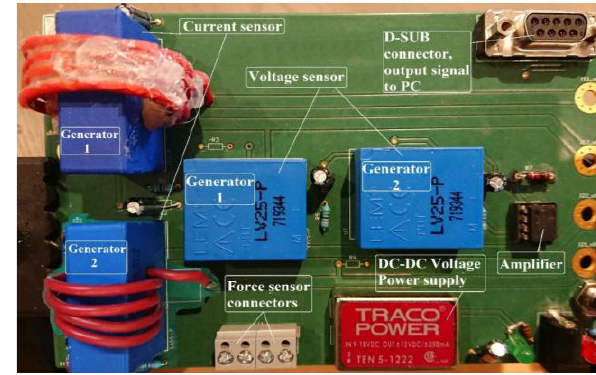
Fig. 8. Measurement